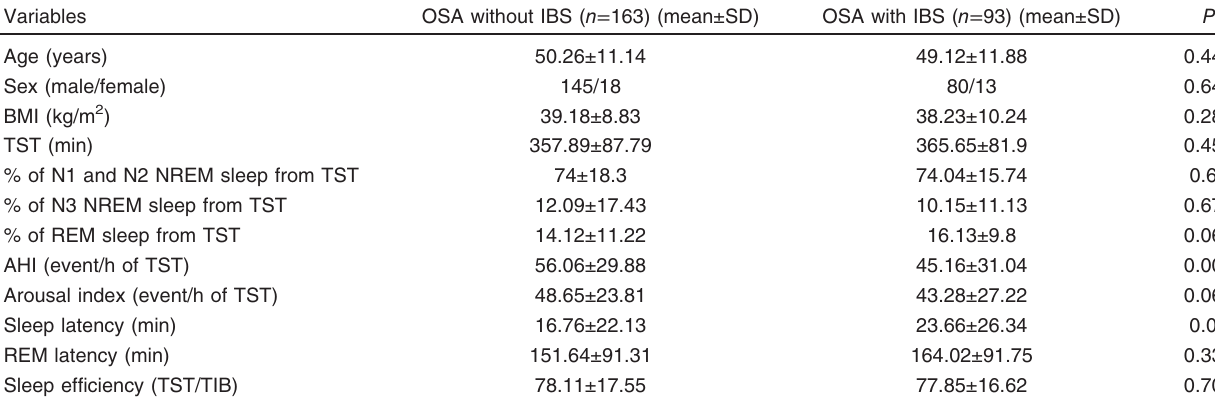
Table 2 Demographic and polysomnographic parameters in obstructive sleep apnea patient subgroups Variables